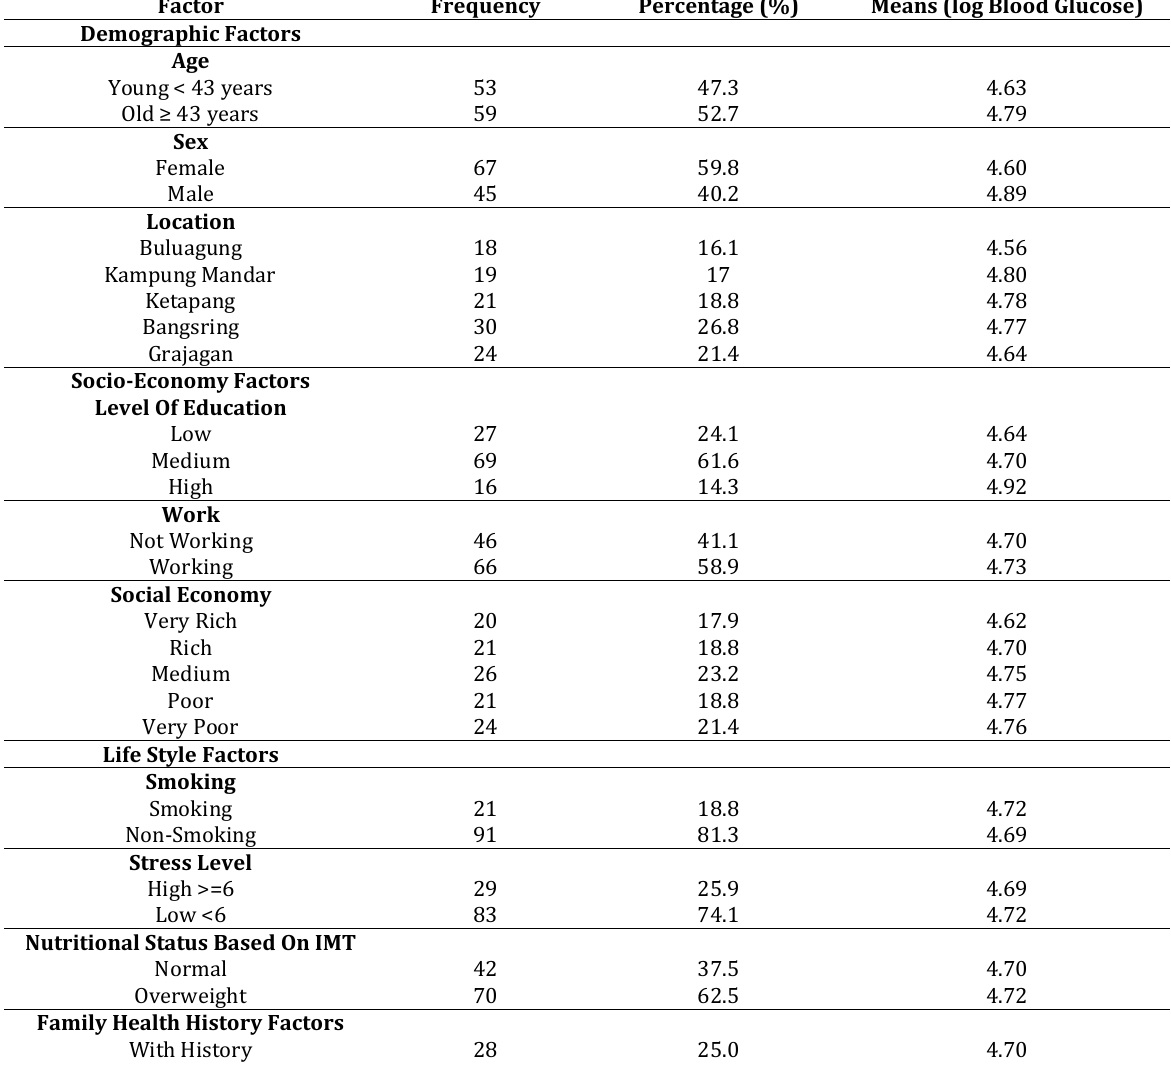
Table 1. Characteristics of